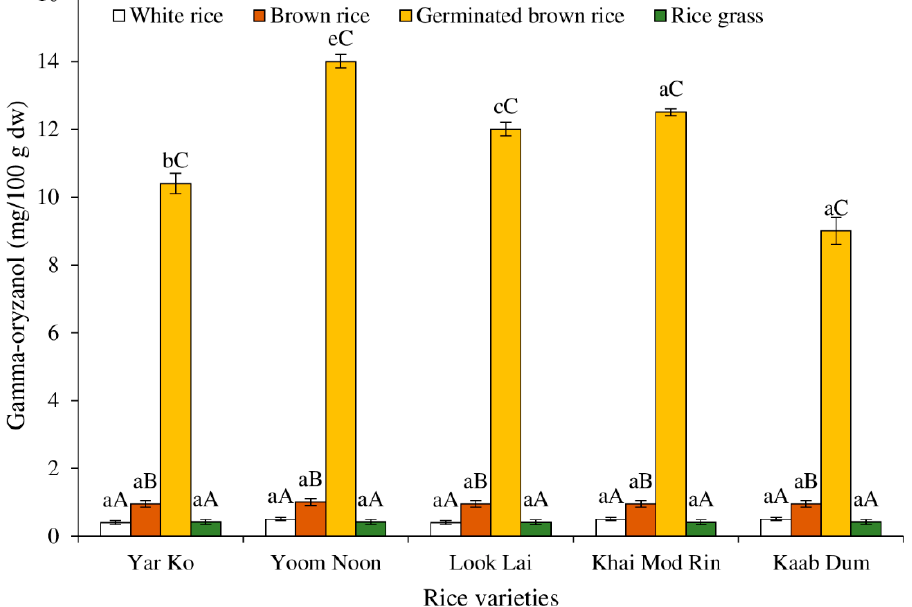
Figure 5. Effect of rice variety and processing condition on γ -oryzanol content of Thai indigenous rice. Bars represent the standard deviations from triplicate determinations. Different lowercase letters within the same processing condition indicate significant differences ( p ˂ 0.05). Different uppercase letters within the same variety indicate significant differences ( p ˂ 0.05).